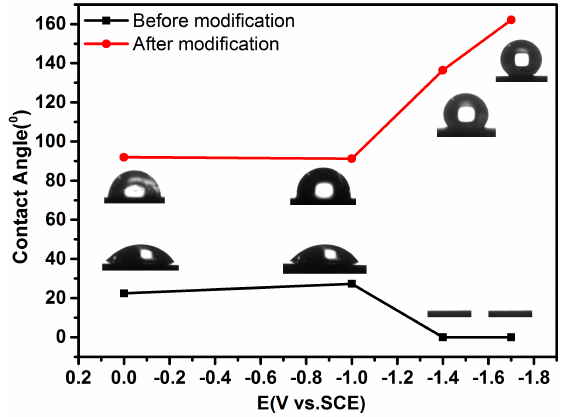
Figure 3. The water contact angles of the samples deposited at different potentials before and after modification by PFTEOS.